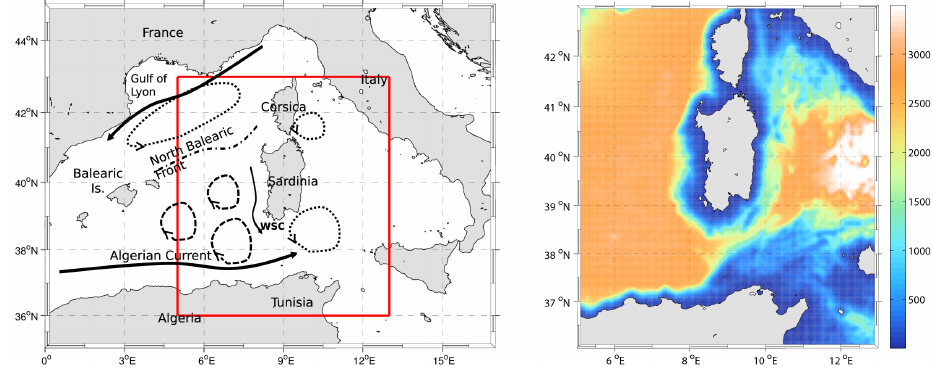
Figure 1. Left: study area with toponyms and main circulation features as known from literature. Right: model domain and bathymetry. The bathymetry used is the GEBCO at 30 (cid:48)(cid:48) of